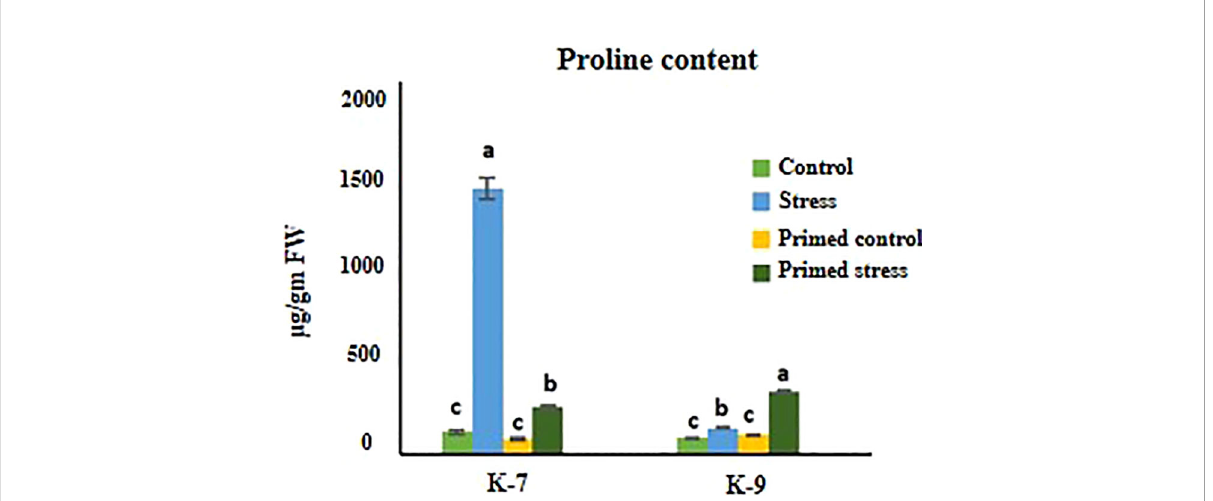
FIGURE 6 Effect of melatonin priming on proline content in drought-sensitive (K-7) and drought-tolerant (K-9) varieties with or without drought stress. Data represents mean values ± SD of minimum 3 independent experiments. Different alphabets within the group represent signi fi cant differences among treatments according to Duncan ’ s multiple range test at P < 0.05.